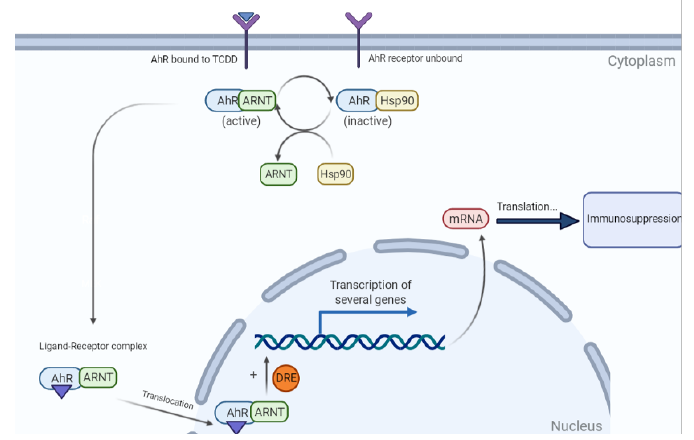
Figure 1. How the aryl hydrocarbon receptor functions.